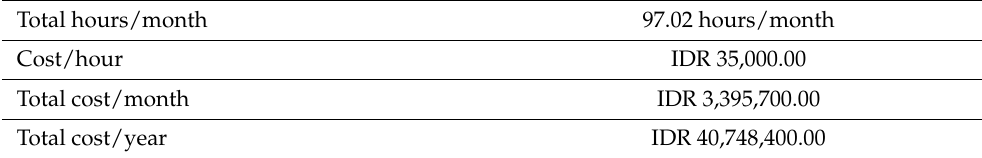
Table 7. Time-saving benefits.